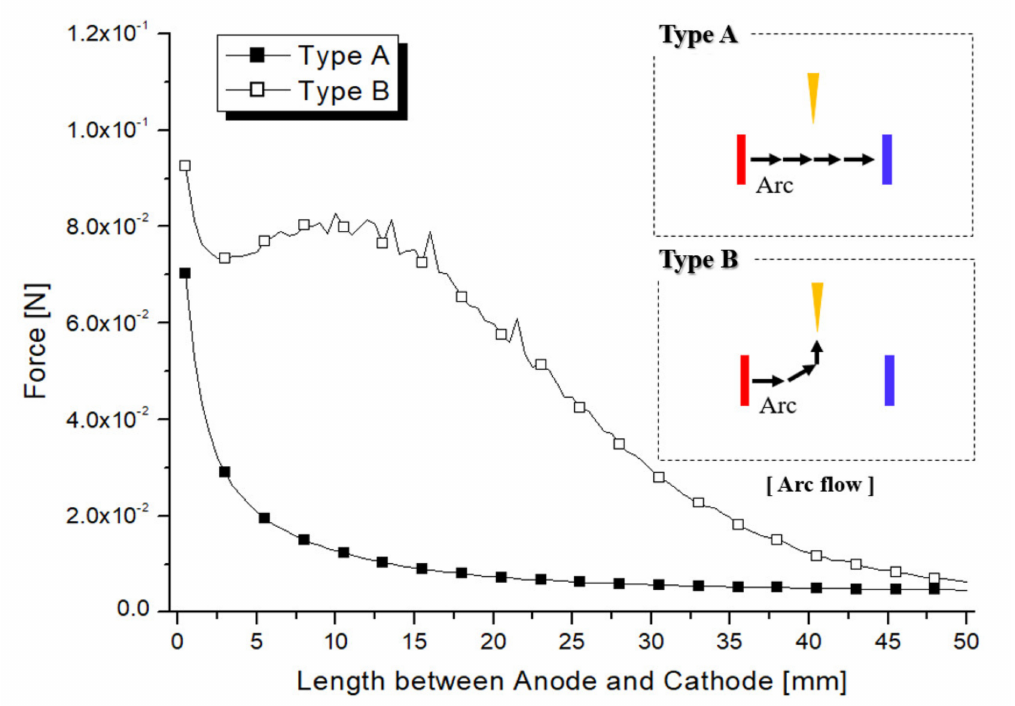
Figure 8. Graphs of the force received by an electron with or without the superconducting